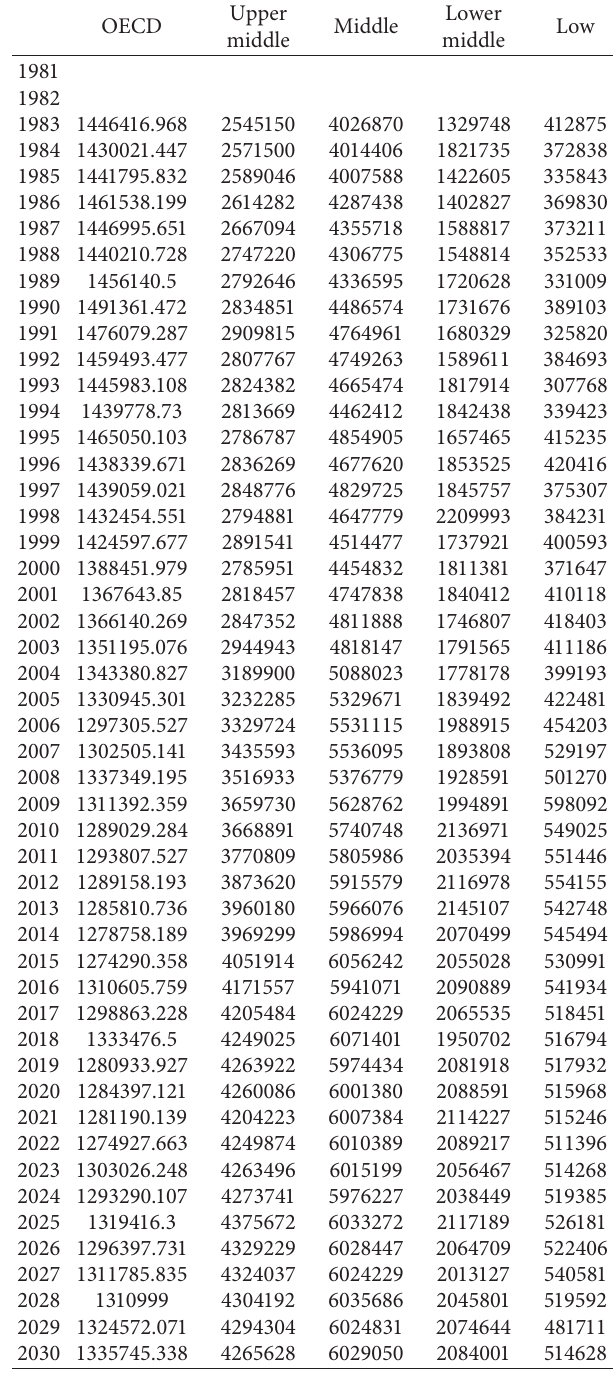
Table 6: Forecasted values of methane emission (in kt CO equivalent) under the ANN